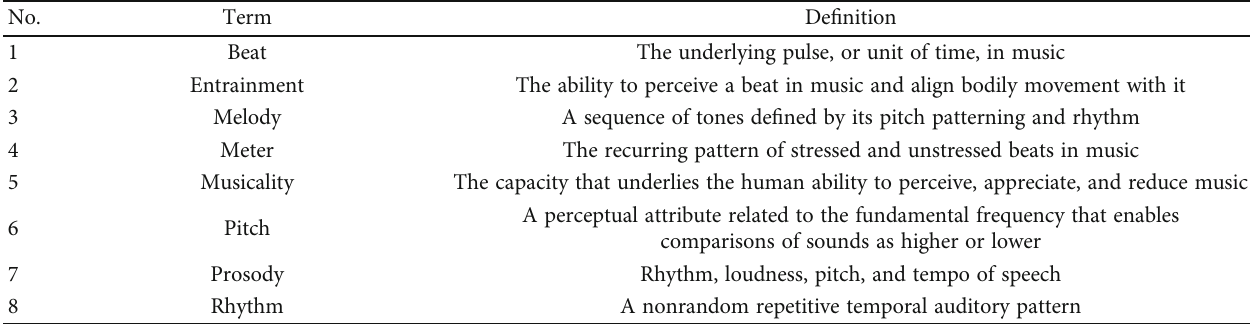
Table 2: List of basic terms in the analysis method [36] (reproduced by Hoeschele et al., under the creative commons (attribution license/ public